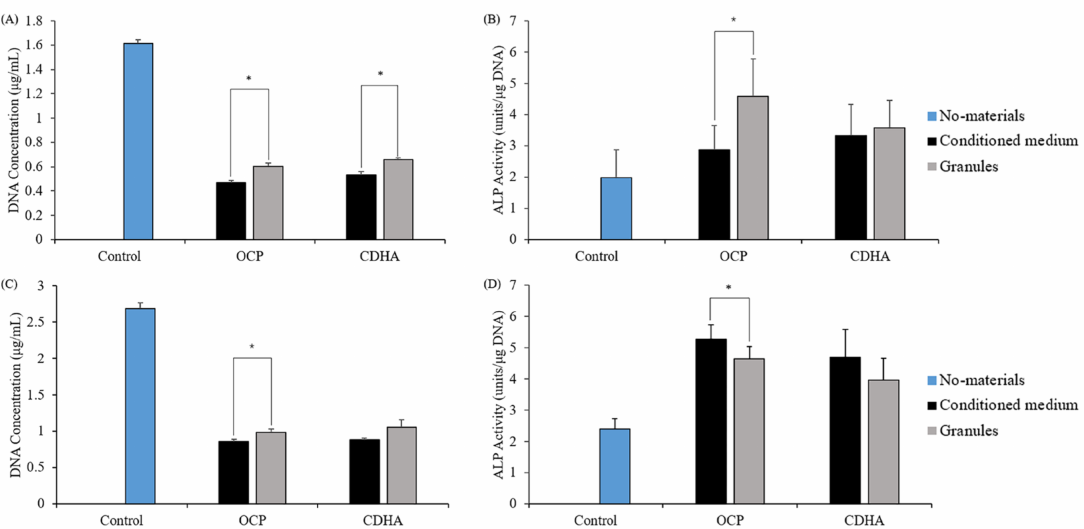
Figure 5. Responses of TSPCs to calcium phosphate conditioned medium; The DNA content of TSPCs treated with OCP or CDHA–conditioned medium for 7 days ( A ) and 14 days ( C ); the ALP activity of TSPCs treated with OCP or CDHA–conditioned medium for 7 days ( B ) and 14 days ( D ); ( n = 3). p <